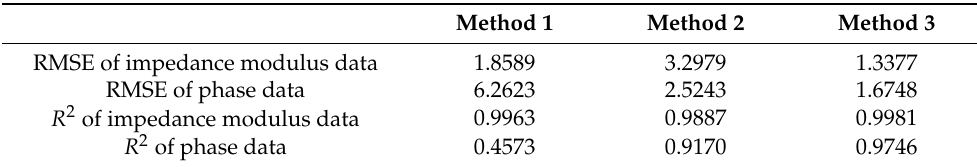
Table 6. The RMSE and R 2 between the experimental data and simulation data.